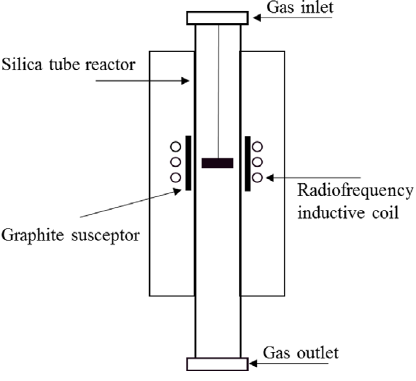
Fig. 1 CVD reactor equipment